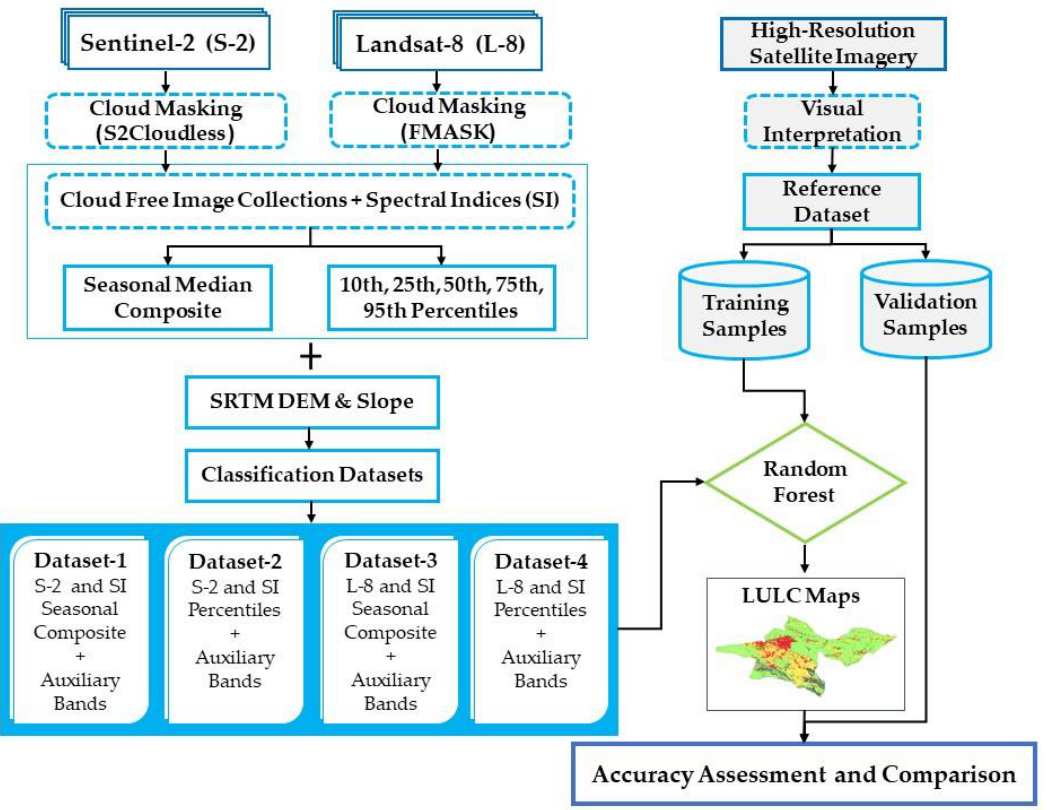
Figure 2. Flow chart of the methodology used in this study for land use/land cover (LULC) mapping.